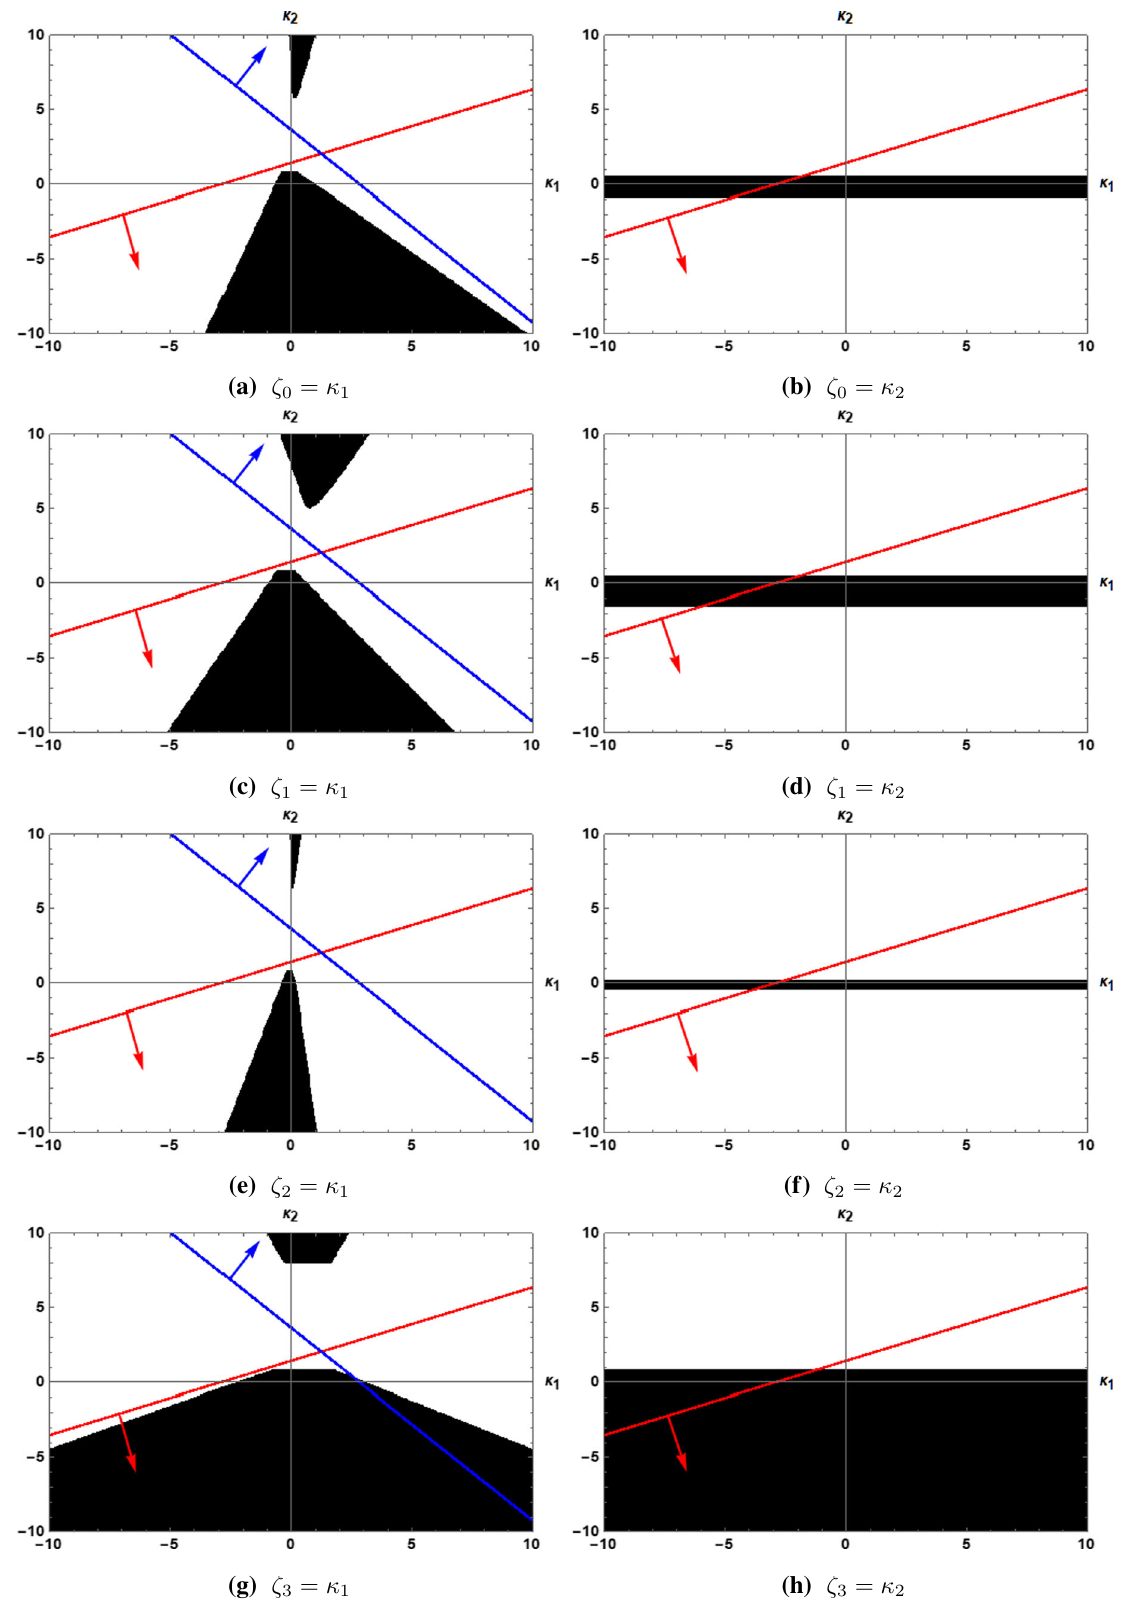
Fig. 5 All figures are depicted for special values, d = 4, A = ± 0 . 1, B = − 2 and ˜ L = 1 .